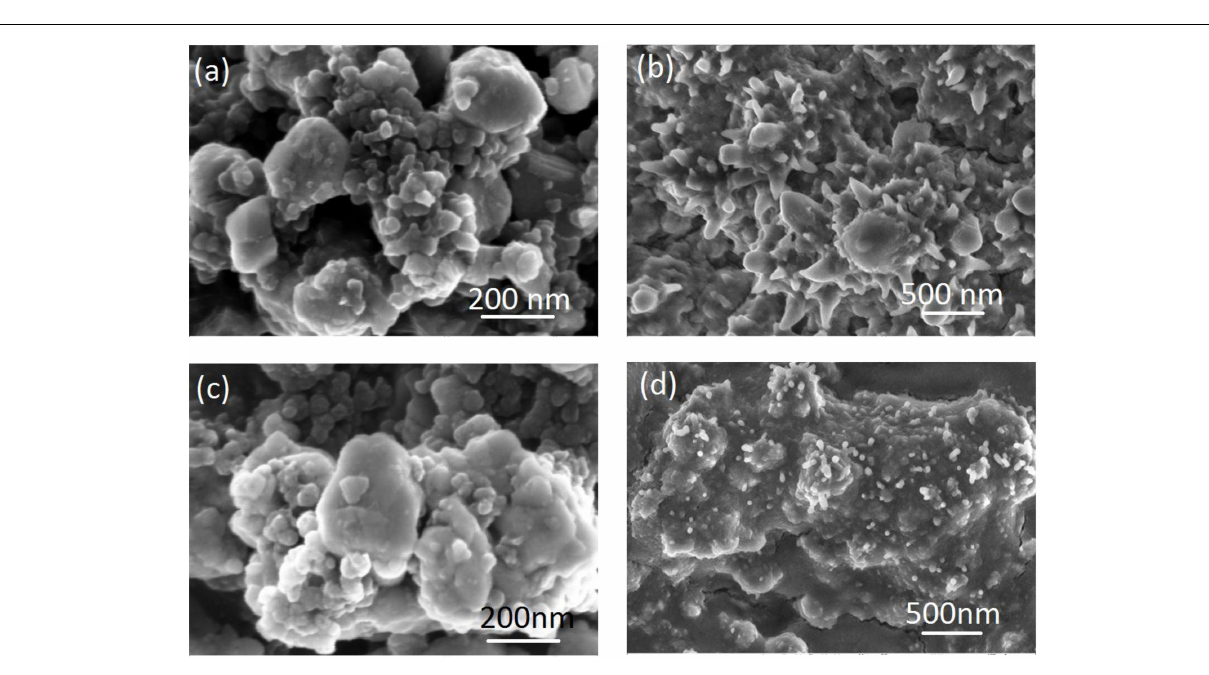
FIGURE 2 | SEM images of Al 2 O 3 coated and bare LTO electrode before/after cycling; bare LTO electrode before (A)/after (B) cycling and Al 2 O 3 -coated LTO electrode before (C)/after (D) cycling